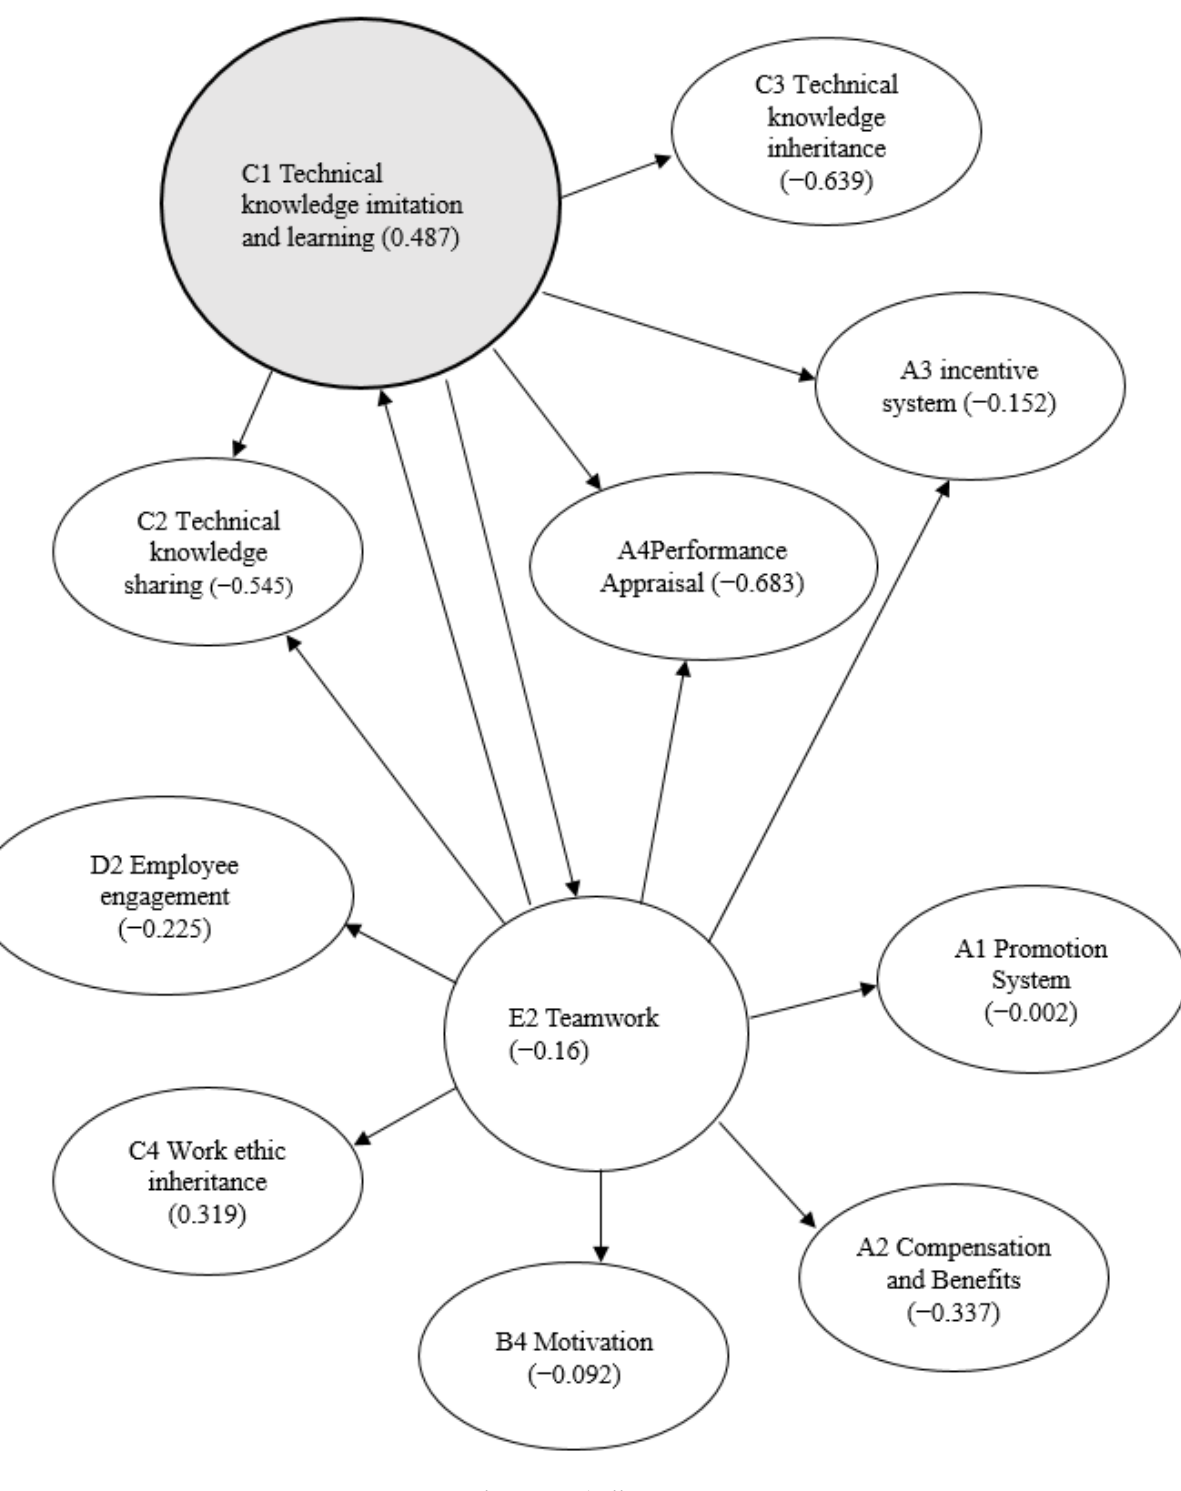
Figure 2. Key criteria of cause and effect.